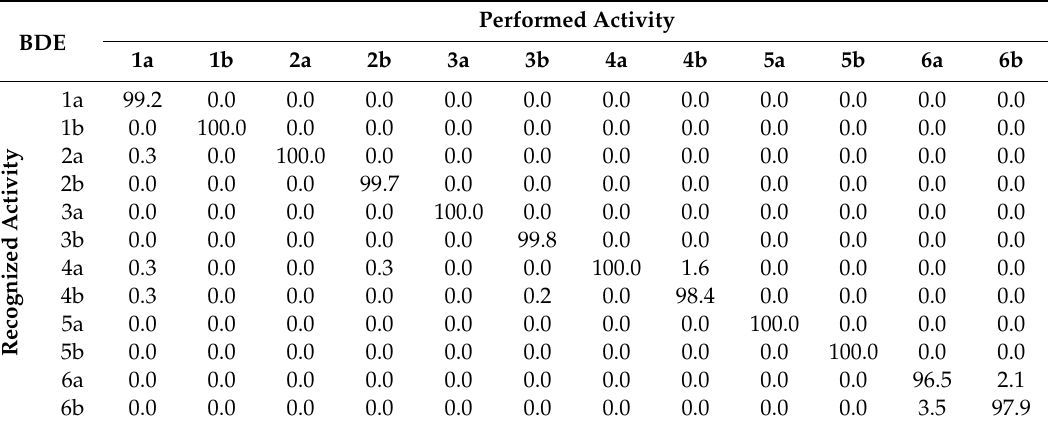
Table A10. Matrix of recognition errors (in %) of 12 motor activities 1a ÷ 6b in test set for all volunteers together for sensor BDE.